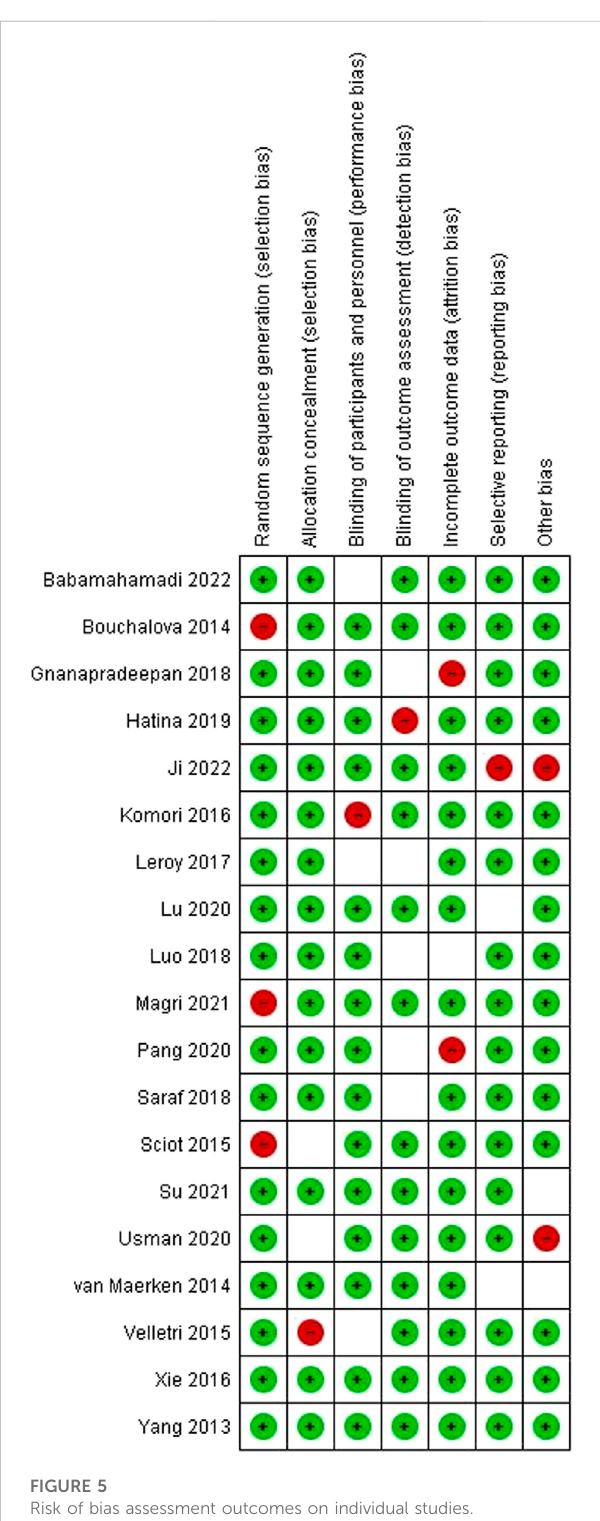
FIGURE 5 Risk of bias assessment outcomes on individual